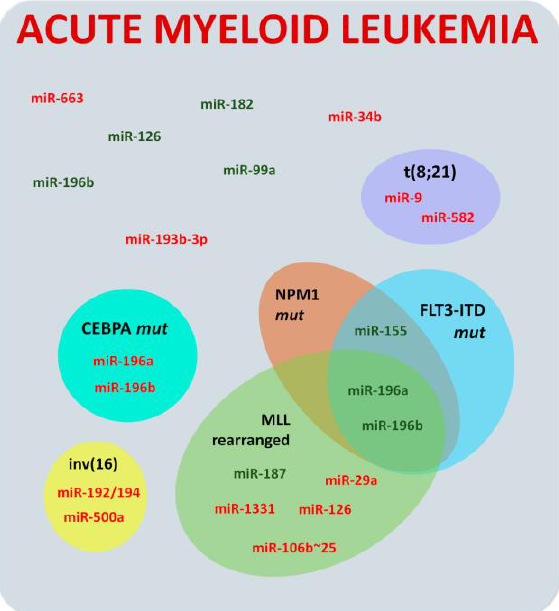
Figure 3. Dysregulated miRNAS in childhood acute myeloid leukemia. Hyperexpressed and hypoexpressed miRNAs in acute lymphoblastic myeloid and cellular/molecular subgroups are denoted in green and red, respectively.